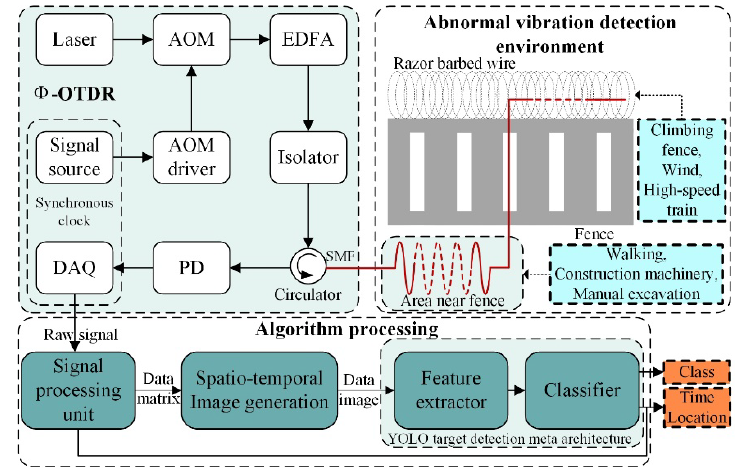
Figure 1. Overall system operation structure.